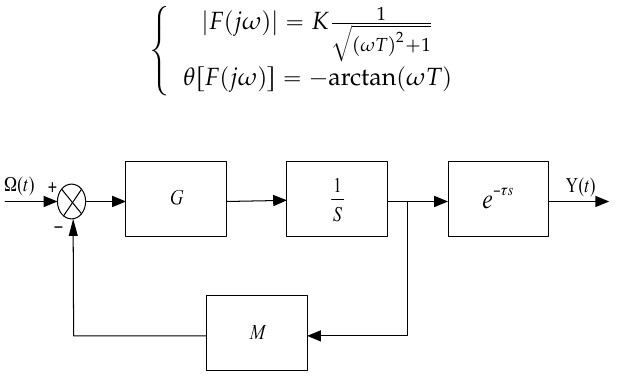
Figure 2. Simplified model of digital closed-loop IFOG.